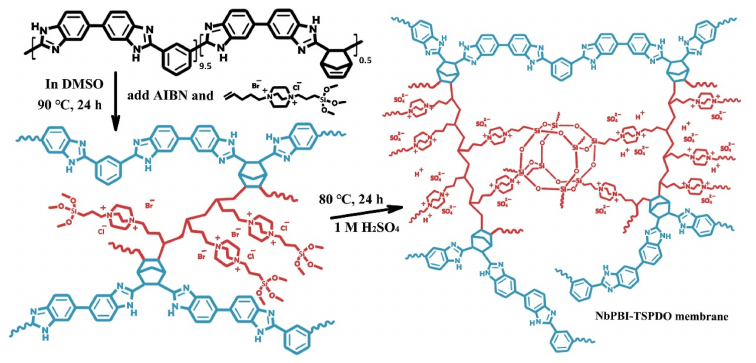
Figure 4. The cross-linked structure of NbPBI-TSPDO (taken from Ref. [67]). Wang’s group reported [68] that three different ionic liquids ([VBIm]Cl, [PMIm]Br and [TPAm]Br) were crosslinked with NbPBI to prepare NbPBI-PIL membranes with three different crosslinking networks. The norbornene monomer of NbPBI could provide cross- linking sites, which combined with the ILs via in situ free radical reactions to